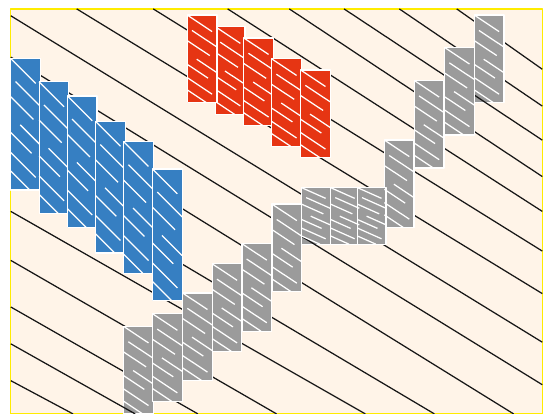
Figure 3: Line segment support